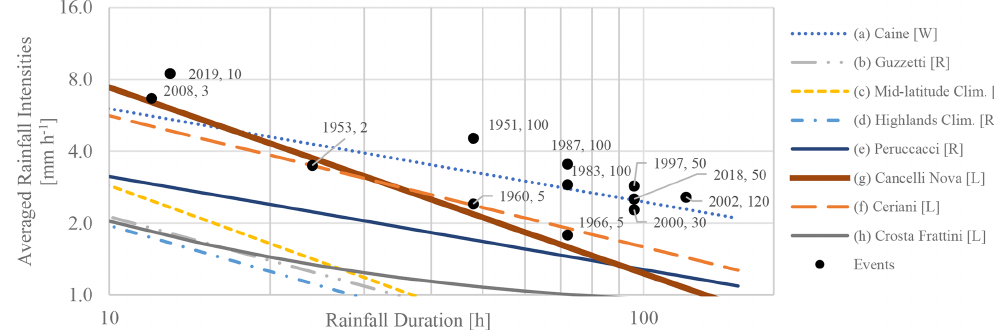
Figure 5. Intensity–duration thresholds for considered events and the relative rainfall RP.